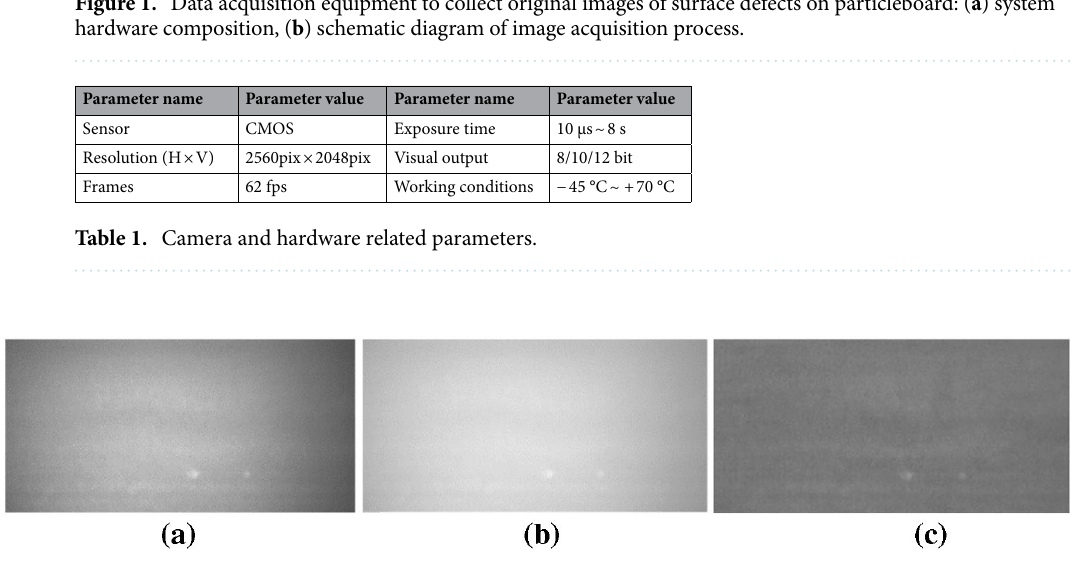
Figure 2. Comparison of illumination nonuniformity before and after correction: ( a ) original image of particleboard, ( b ) gamma transformation result, ( c ) gamma transform and image difference result